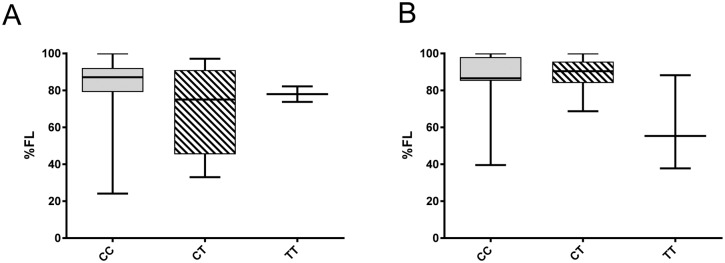
Proportions of the full-length isoform expressed from the CD40 risk allele in whole blood.Association of rs1883832 genotype (CC, TC, TT) with the proportion of full-length isoform of CD40 (%FL) expressed in whole blood from healthy controls (A; n = 38) and MS (B; n = 32). Molar ratios of isoforms were quantitated by RT-PCR and amplification of a region spanning CD40 exon 4–10, followed by electrophoretic separation and fluorescent detection (Bioanalyzer, Agilent). Trends were observed for CC > CT in controls (p < 0.13) and for CT > TT in MS, (p < 0.056); p values by Mann-Whitney test.